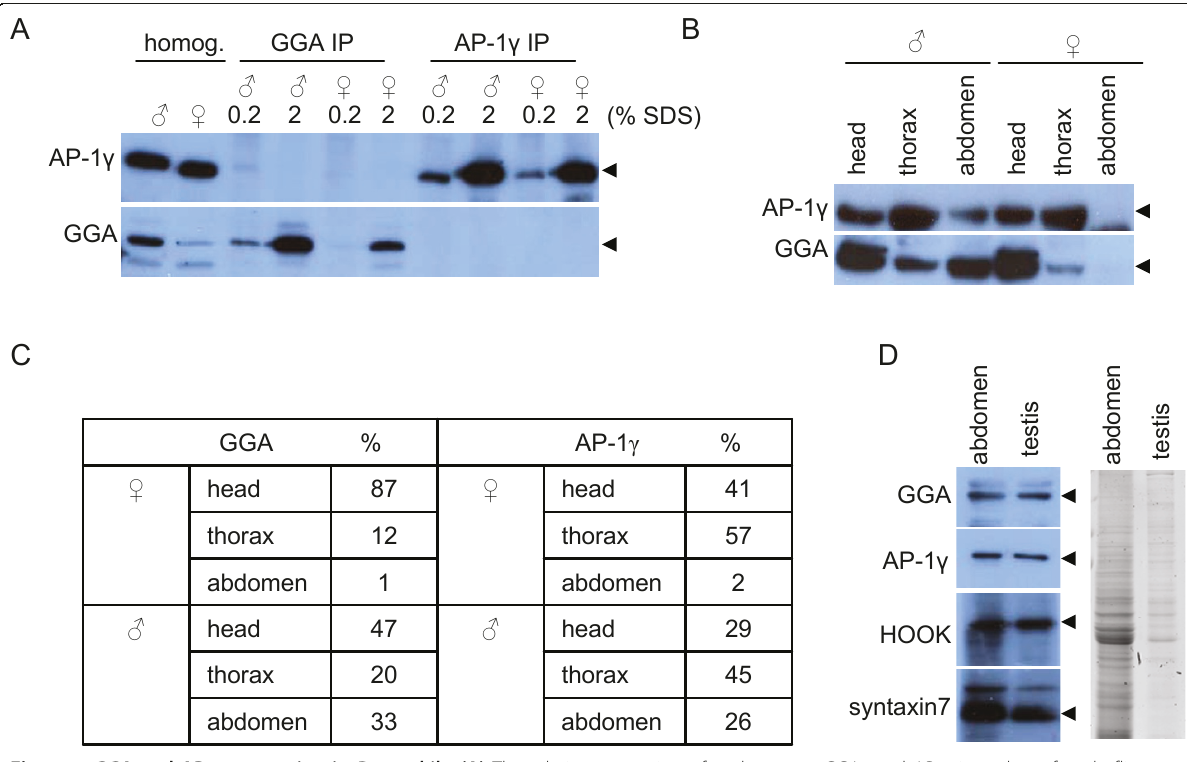
Figure 1 GGA and AP-1 expression in Drosophila . (A) The relative expression of endogenous GGAs and AP-1 in male or female flies was determined in whole fly homogenates (homog.) or by immunoprecipitations (IP). The final elutions were done with either 0.2% SDS (0.2) or more harshly with 2% SDS (2). Note that AP-1 is expressed in similar amounts, but GGA is expressed >3 fold higher in the males. (B) Male or female flies were dissected into head, thorax and abdomen, Western blotted for AP-1 or GGA, and quantitated in (C) . Note that GGA is highly expressed in male abdomens. (D) The relative expression of GGA and AP-1 were compared in the testes of 5 flies compared to 5 abdomens. Coomassie gel shows the relative protein